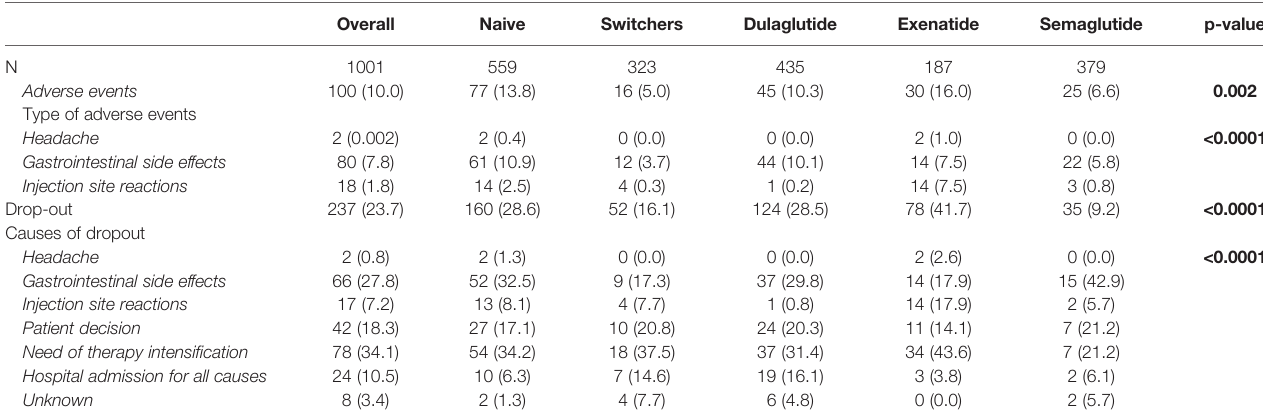
TABLE 4 | Safety endpoints overall and by